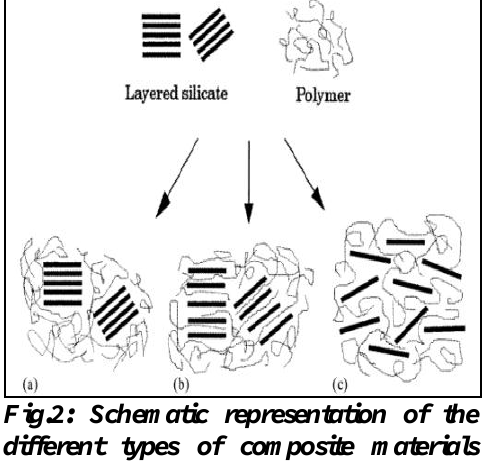
Fig.2: Schematic representation of the different types of composite materials generated on the basis of the interactions of the silicate layers with polymer matrices. (a) the separation of the small boat stage, (b) nanocomposite intercalated and (c) nanocomposite crusting